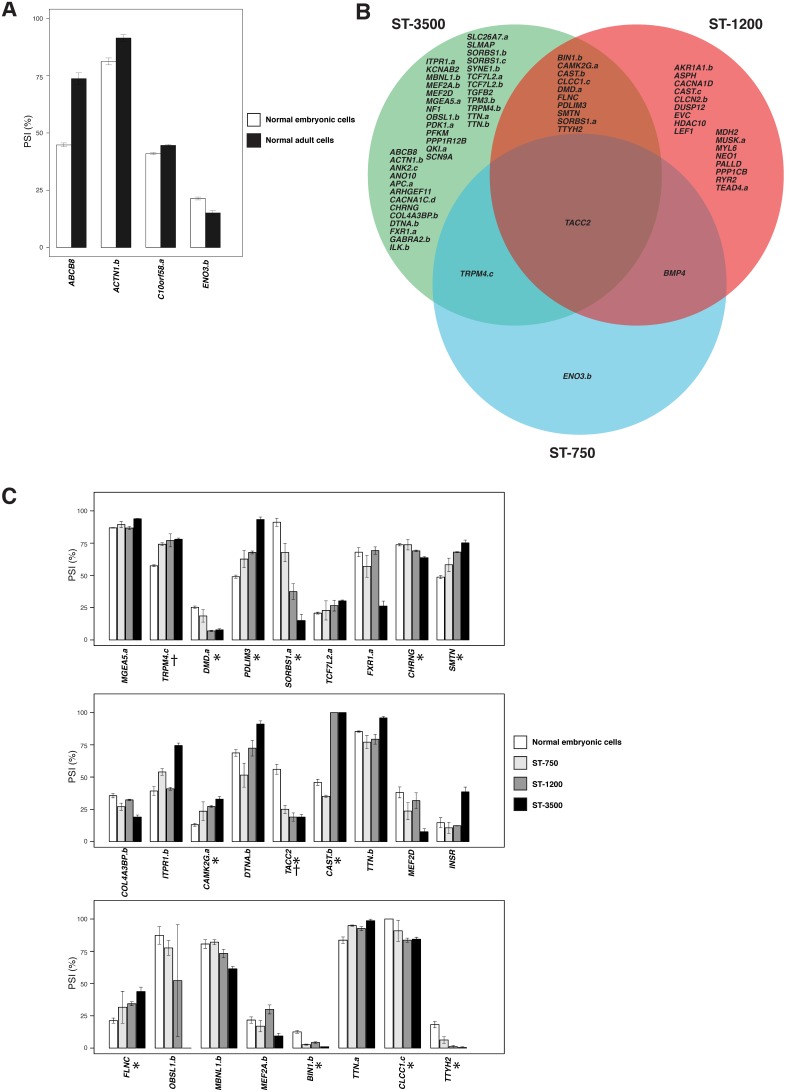
Differences in alternative splicing events (ASEs) when normal adult muscle cell lines are compared to normal embryonic muscle cell lines.(A–C) A. Histograms representing the four ASEs (ABCB8, C10orf58, ACTN1, ENO3) that are differentially spliced when normal embryonic cell lines (white bars) are compared to normal adult cell lines (black bars). B. Venn diagram representing hits when the three embryonic cell line categories (ST-750, ST-1200, and ST-3500) were compared to normal fetal cell lines. C. Histograms representing Ψ values in the normal fetal (white bars), ST-750 (light grey bars), ST-1200 (dark grey bars) and ST-3500 cells (black bars). Only the top 27 of the 50 splicing alterations seen in ST-3500 (q ≤ 0.05) are shown which also include all ST-750 (†) and ST-1200 (*) hits (respective q≤0.05) relative to normal fetal cells.